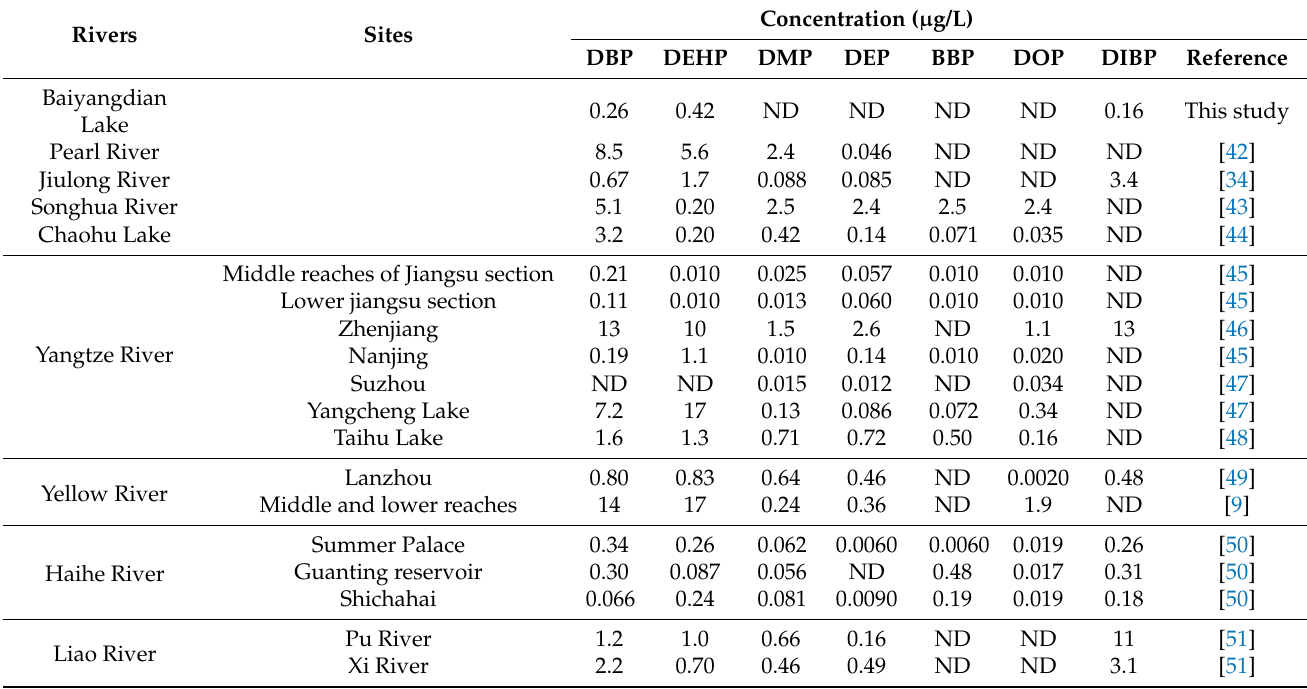
Table 2. Exposure data of PAEs in typical rivers in China ( µ g/L).